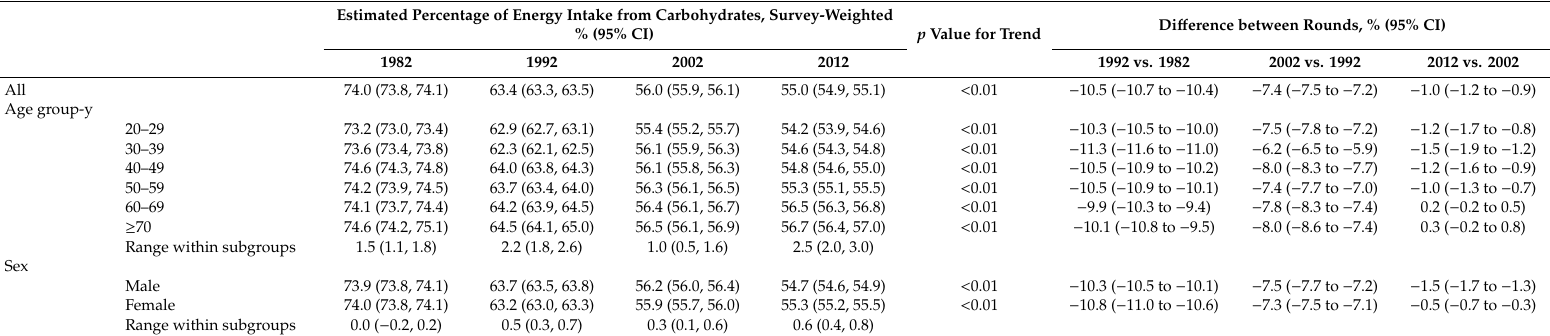
Table A3. Trends and Disparities in the Estimated Percentage of Energy Intake from Carbohydrates of Adults Aged 18 Years or Older by CNNS Round, 1982–2012 1 . Estimated Percentage of Energy Intake from Carbohydrates, Survey-Weighted % (95% CI) p Value for